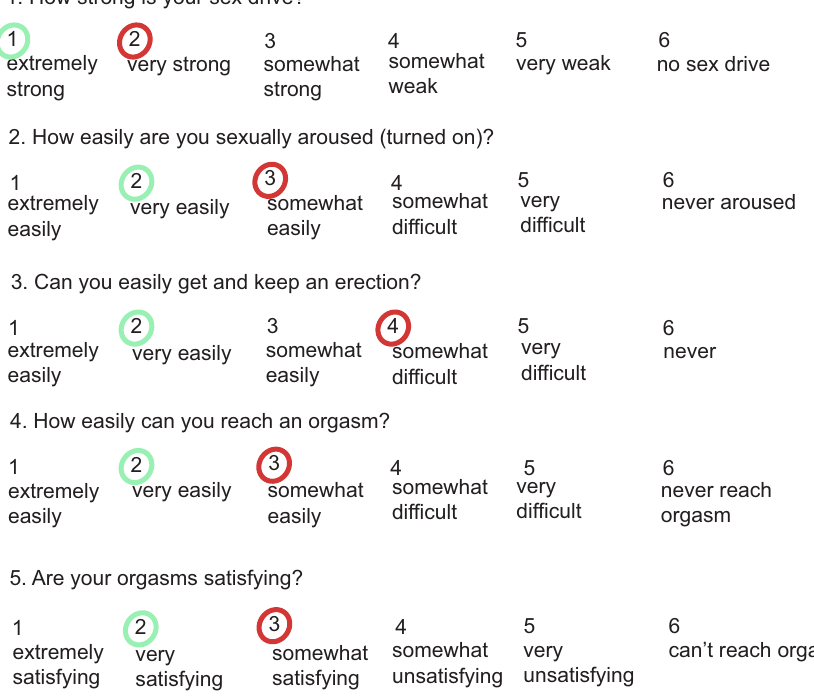
Figure 1. Mr. A’s Arizona Sexual Experience Scale revealing that paid sex is less intense compared with romantic sex.